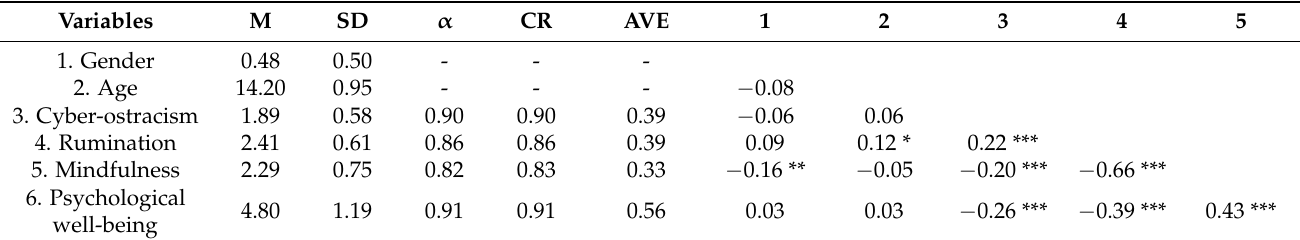
Table 1. Descriptive statistics and Pearson’s correlation coefficients.